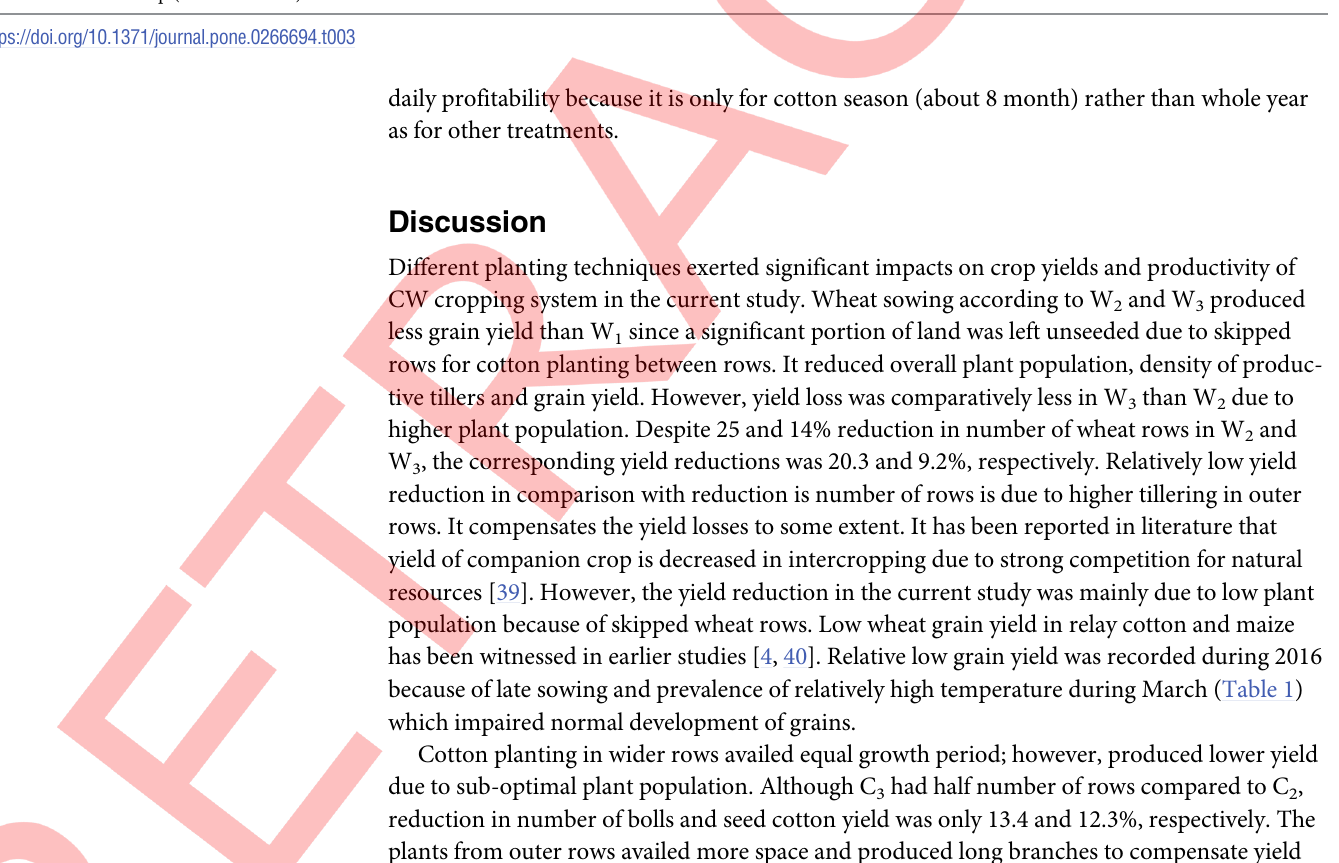
W 1 C 4 = conventional wheat-cotton sowing, W 2 C 2 = wheat-cotton relay cropping system (R × R = 75 cm), W 3 C 3 = wheat-cotton relay cropping system (R × R = 150 cm), C 1 = cotton as sole crop (R × R = 150